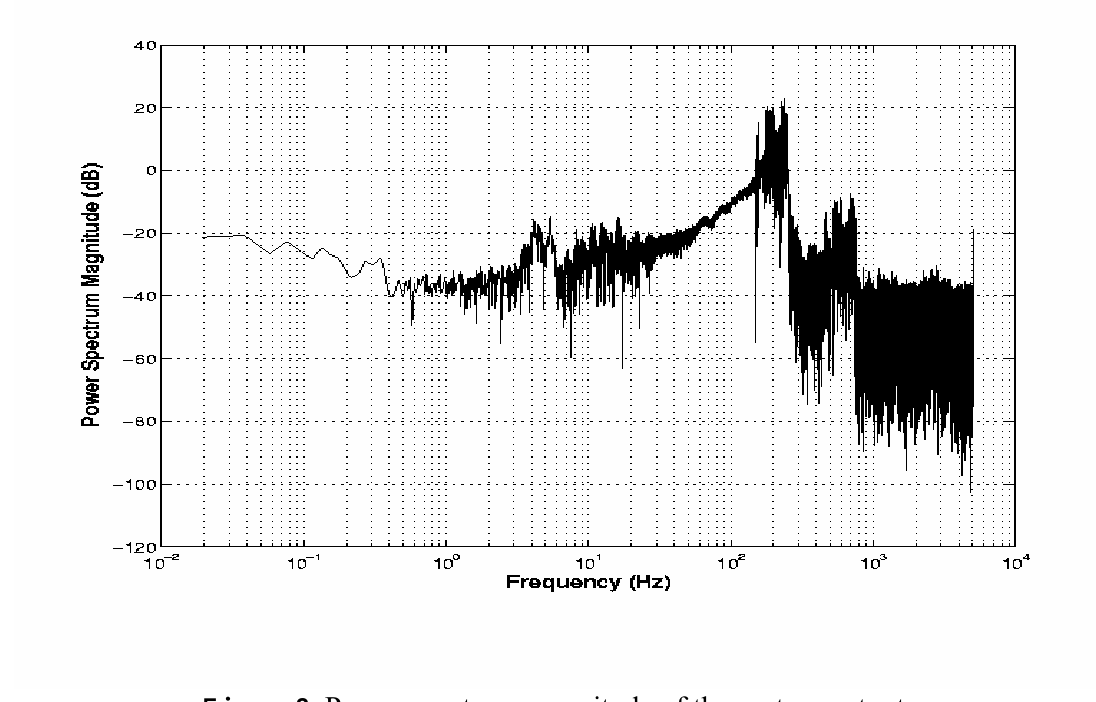
Figure 8. Power spectrum magnitude of the system